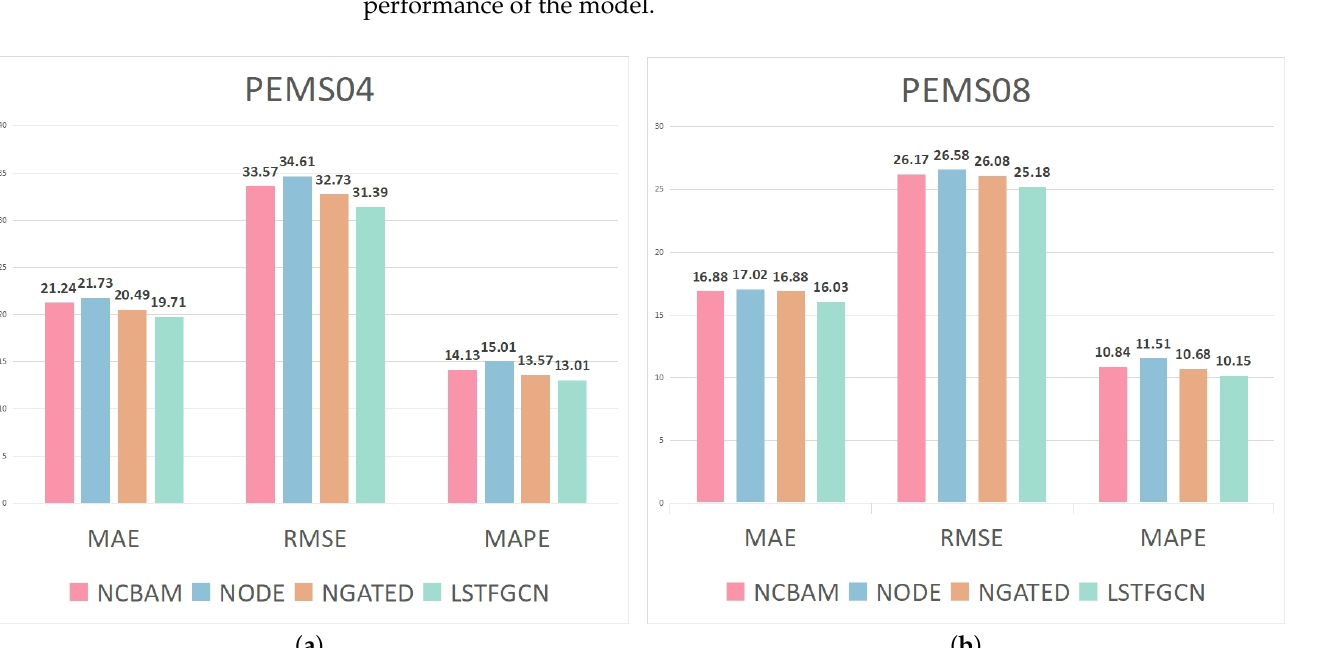
Figure 8. The experimental results of different variant models: ( a ) all three evaluation metrics of the variant model on PEMS04; ( b ) all three evaluation metrics of the variant model on